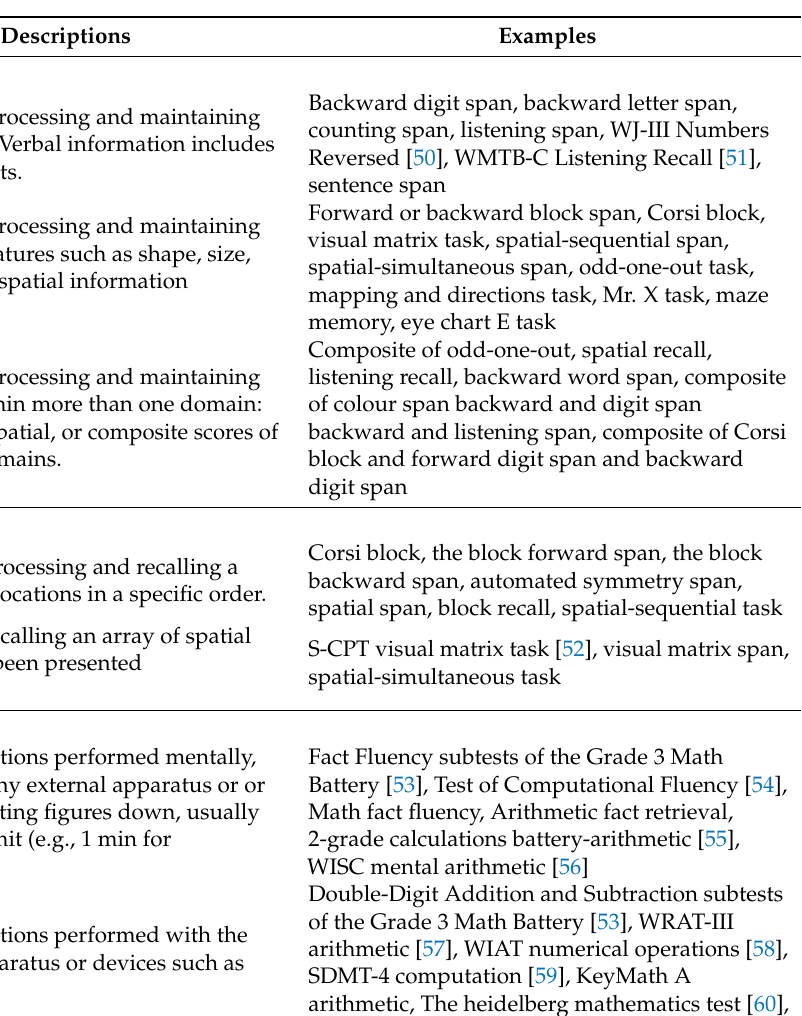
Table 1. Descriptions of WM domains, subtypes of spatial WM, and arithmetic task